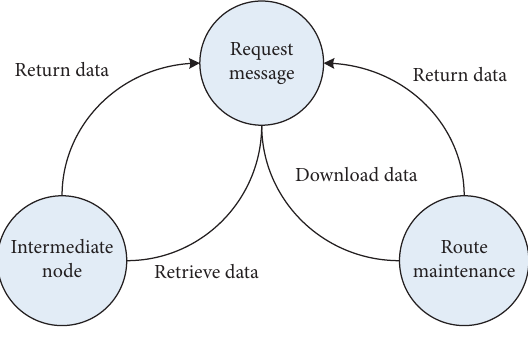
Figure 7: Implementation of the routing algorithm.